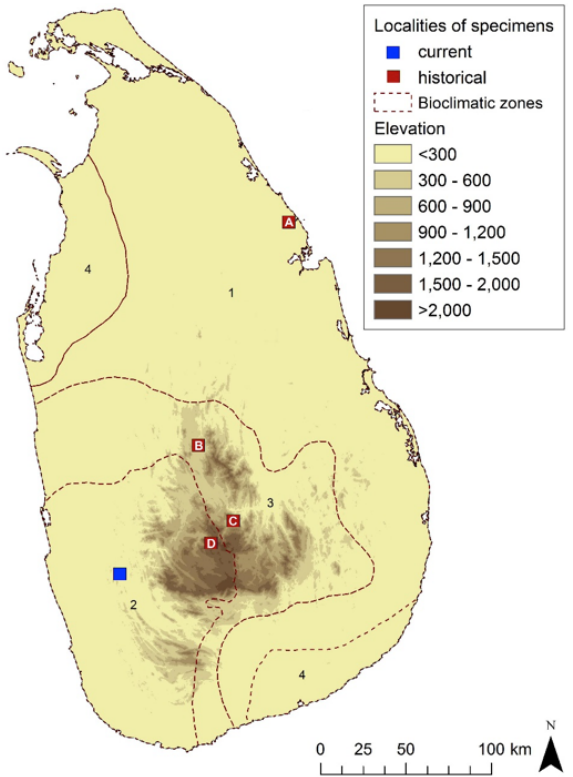
Figure 1. Historical and current distribution of Kerivoula hardwickii in Sri Lanka: Historical locations are according to Phillips (1980), Bates & Harrison (1997), and Slade (2017): (a) Nilaweli, (b) Pallama, (c) Kumbalgamuwa, (d) Pundaluoya, and new locality at Thoranagoda (blue square). Bioclimatic zones of Sri Lanka: (1) lowland dry zone, (2) lowland wet zone, (3) intermediate zone, and (4) arid